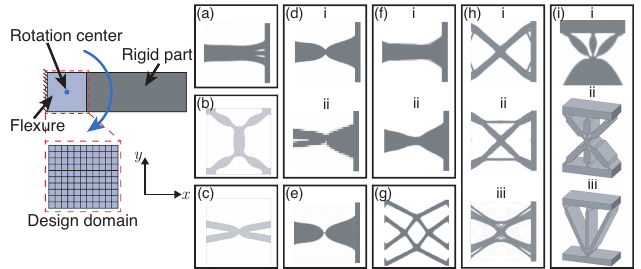
Figure 13. Schematicdescription ofthe TopologyOptimization process todesignthe optimalconfiguration of SARFJ using a 2D rectangular design domain. Optimal designs were obtained in (and adapted from) ( a ) [207]; ( b ) [208]; ( c ) [209]; ( d ) [210] i-design based on linear FEA and ii-design based on nonlinear FEA; ( e ) [211]; ( f ) [212] i-design with less stress allowed for a mesh of 50 × 50 and ii-design with less stress allowed for a mesh of 100 × 100; ( g ) [213]; ( h ) [214] i-design for general distributed flexure hinges, ii-design for distributed flexure hinges with prescribed compliances, and iii-design for distributed flexure hinges with minimal parasitic motion; and ( i ) [56] i-optimal topology, ii-simplified design named “Snowflake”, and iii-simplified design named